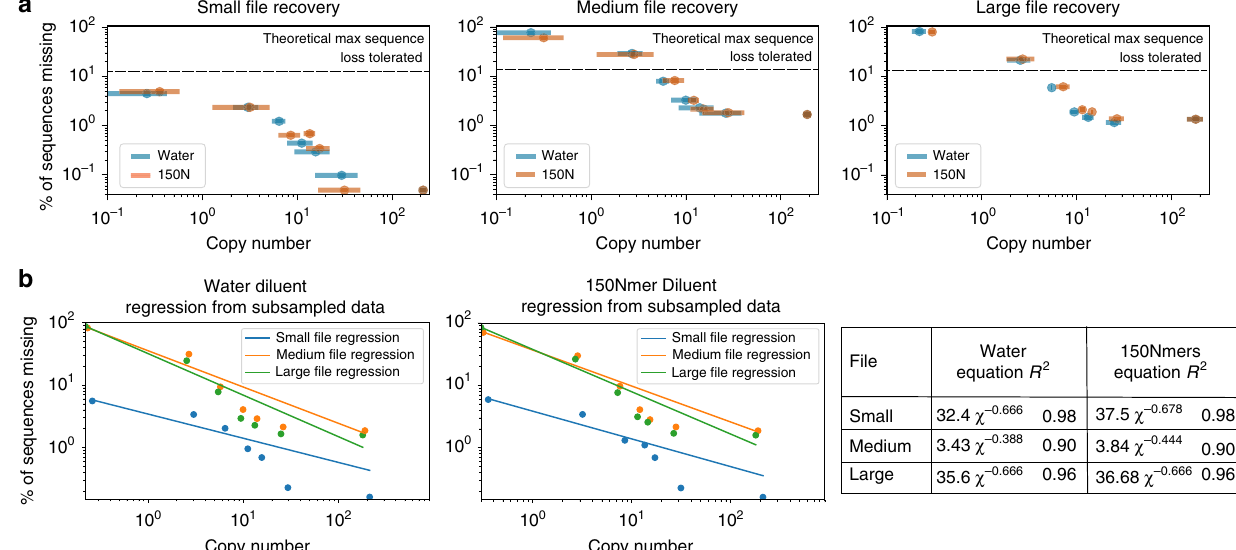
Fig. 2 Examining sequence loss behavior. a Each plot illustrates a fi le's loss of sequences recovered at 20× coverage, directly comparing the samples diluted in water to those diluted in 150 Nmers (150nt sequences comprised of random nucleotides). The threshold of the maximum number of sequences that can be lost while still permitting fi le recovery is plotted for reference, as determined by previous work 10 . Error bars represent 95% con fi dence intervals; x -axis errors are taken from triplicate qPCR data (see Methods), and y -axis errors are the result of 100 simulations of the original sequencing data sub- sampled to 20× sequencing coverage (see Methods). b Each plot illustrates behavioral similarities for each fi le in each diluent condition, with a power regression overlayed (see Supplementary Note 4). The data used here are also sub-sampled to a sequencing coverage of